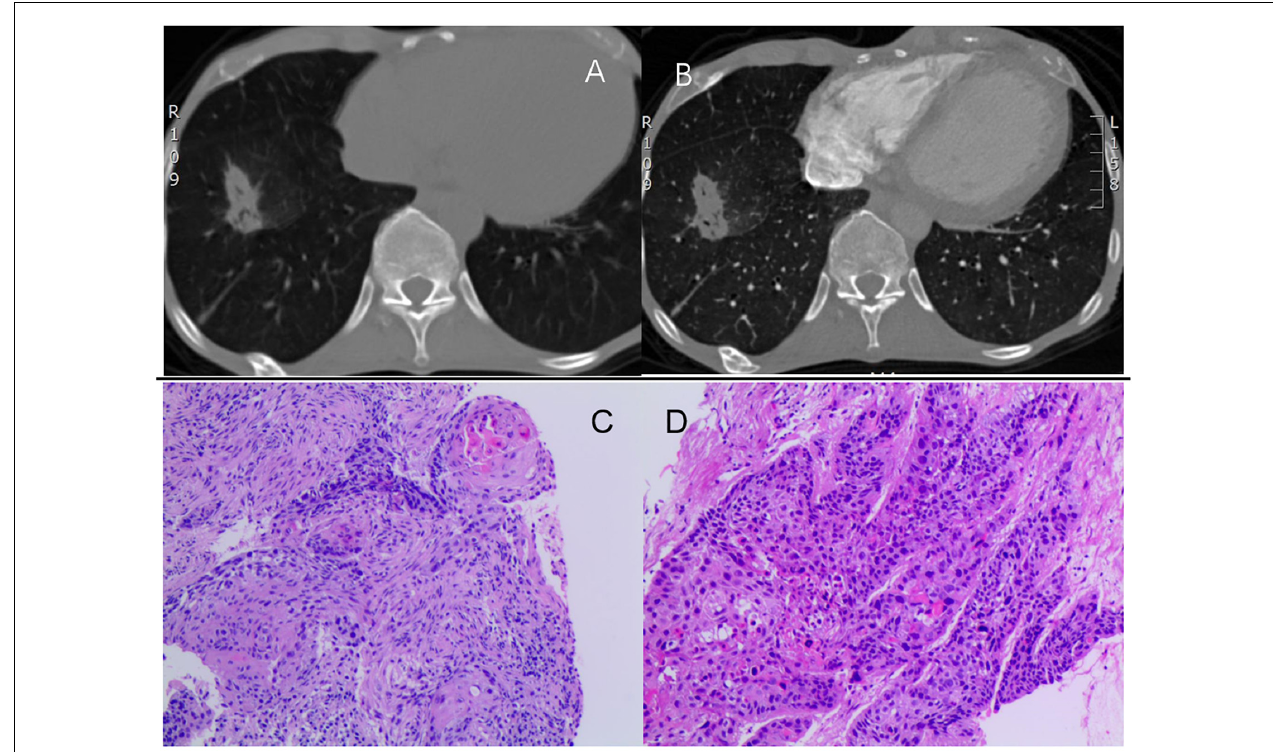
FIGURE 2 | (A,B) Computed tomography showing a spiculated mass (35 × 20 mm) in the lower right lung lobe. (C,D) H&E staining identifying lung squamous cell carcinoma with no keratinization but well-defined nests. H&E, hematoxylin and eosin